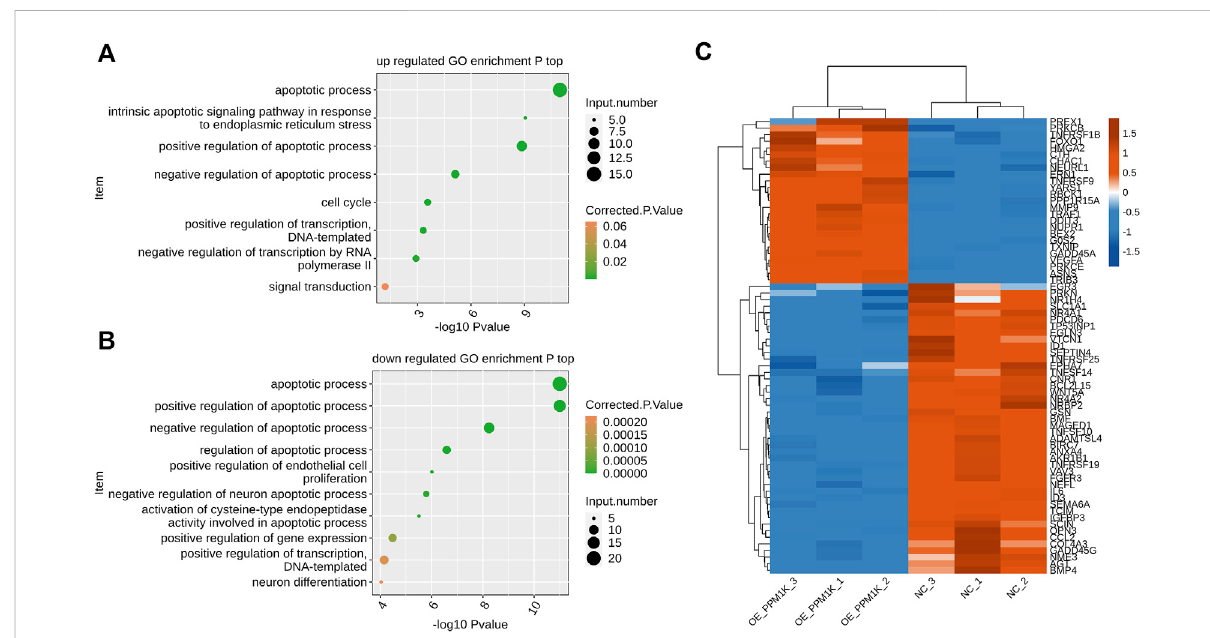
FIGURE 3 PPM1K regulated expression of apoptosis associated genes in HK2 cells (A) Scatter plot exhibiting the most enriched GO biological process results of the all up-regulated genes of apoptosis-related (top) (B) Scatter plot exhibiting the most enriched GO biological process results of the all down-regulatedgenesofapoptosis-related(bottom). (C)